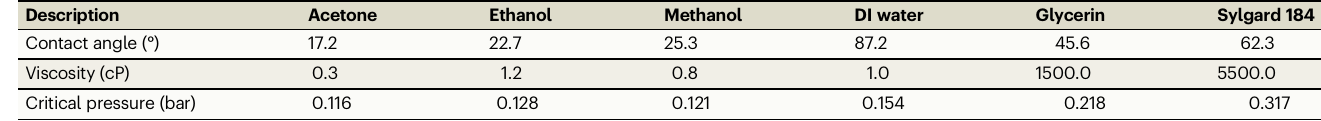
Table 1 | The relationship between liquid properties and critical